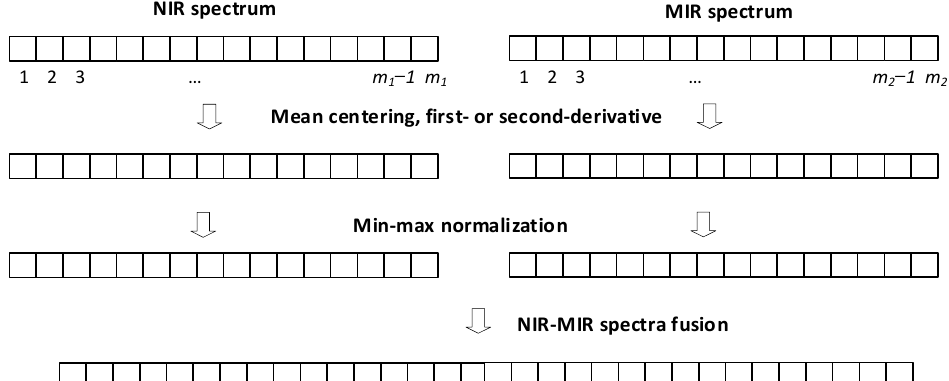
Figure 3. Summary of data-fusion strategy applied in this paper.